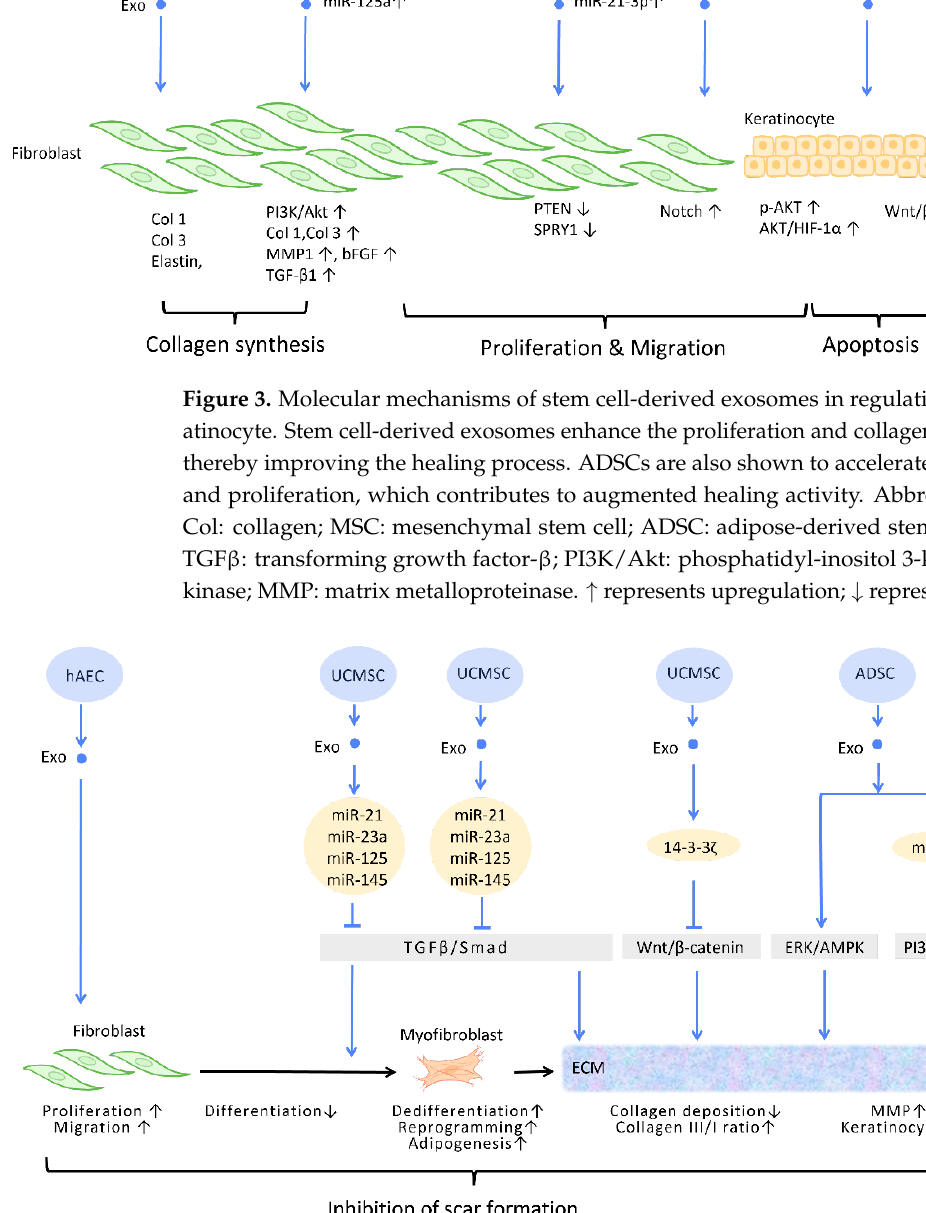
Figure 4. Molecular mechanisms of stem cell-derived exosomes in inhibition of scar formation and promotion of ECM remodeling. In the process of tissue repair, excessive accumulation of myofibroblasts and deposition of collagen result in aberrant scar formation. By controlling fibroblast transition and ECM remodeling, administrations of stem cell-generated exosomes have the potential to limit scar formation. Abbreviation: ECM: extracellular matrix; ERK: extracellular signal-regulated kinase; MAPK: mitogen-activated protein kinase; PI3K/Akt: phosphatidyl-inositol 3-kinase/serine-threonine kinase; MMP: matrix metalloproteinase. ↑ represents upregulation; ↓ represents downregulation.